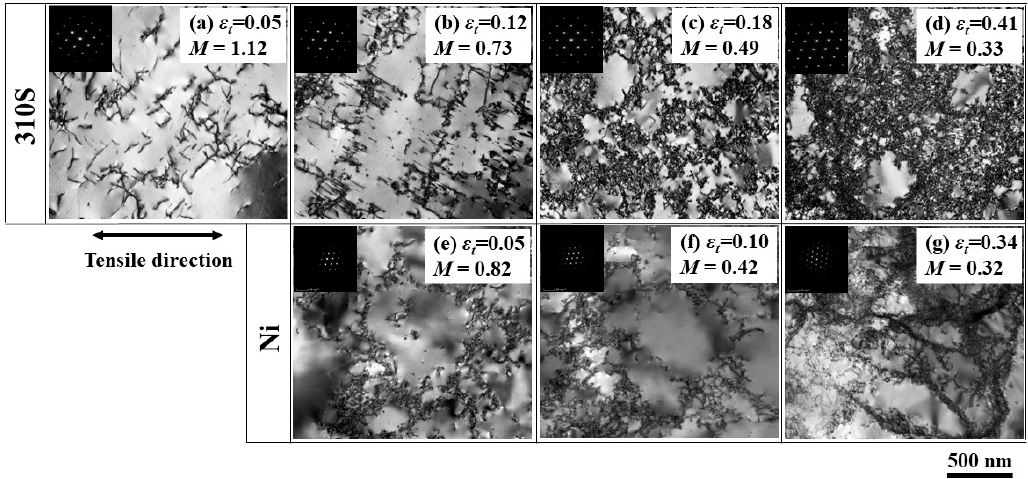
Figure 7. TEM images of tensile-deformed 310S ( a – d ) and Ni ( e – g ) at true strains ( ε t ) of 0.05, 0.12, 0.18, 0.41, 0.05, 0.10, and 0.34, respectively.